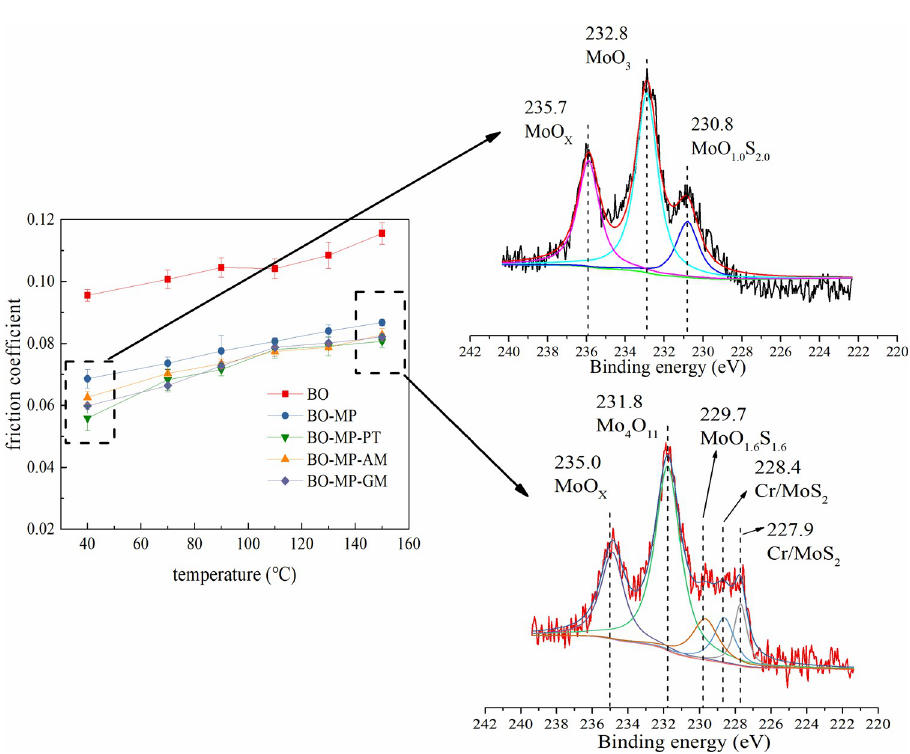
Fig 14. The XPS photopeaks of Mo3d lubricated with MoDDP (MP) containing lubricants.